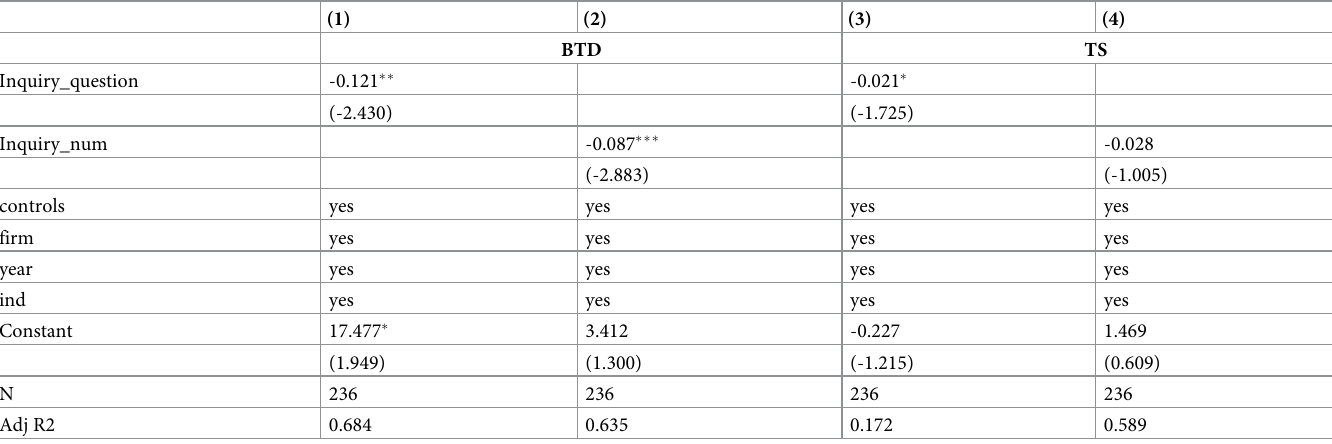
Table 11. The impact of tax-related comment letter text